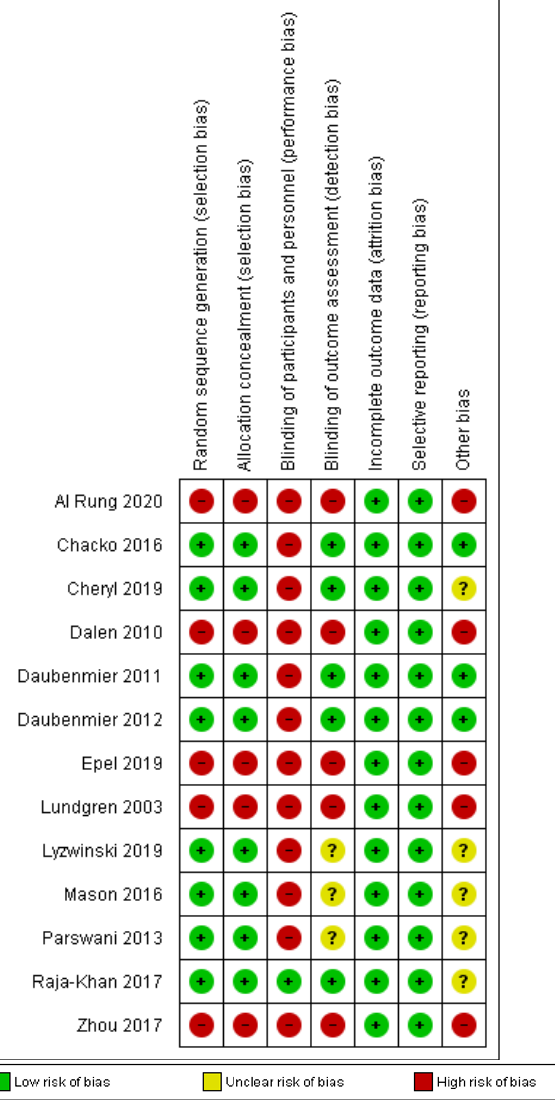
Figure 2. Risk of bias: reviewers ’ judgments of each element of risk of bias are presented as percentages across all included studies.